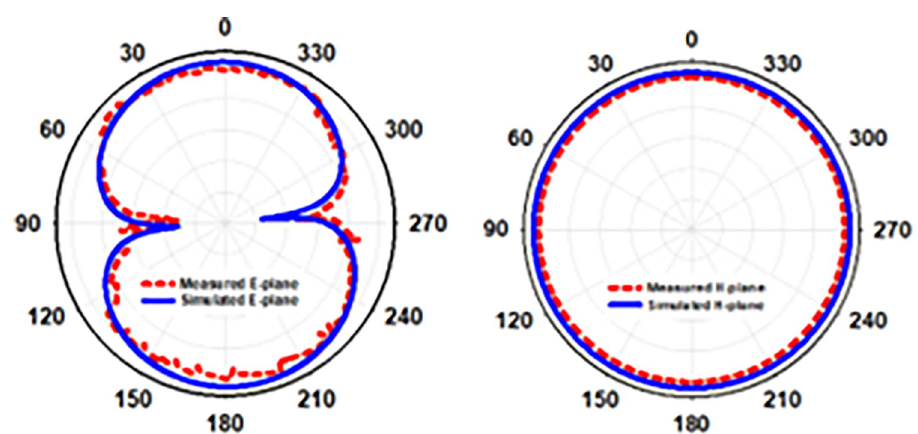
Fig 14. Radiation pattern of antenna in free space when bent along y-axis (By = 30mm).